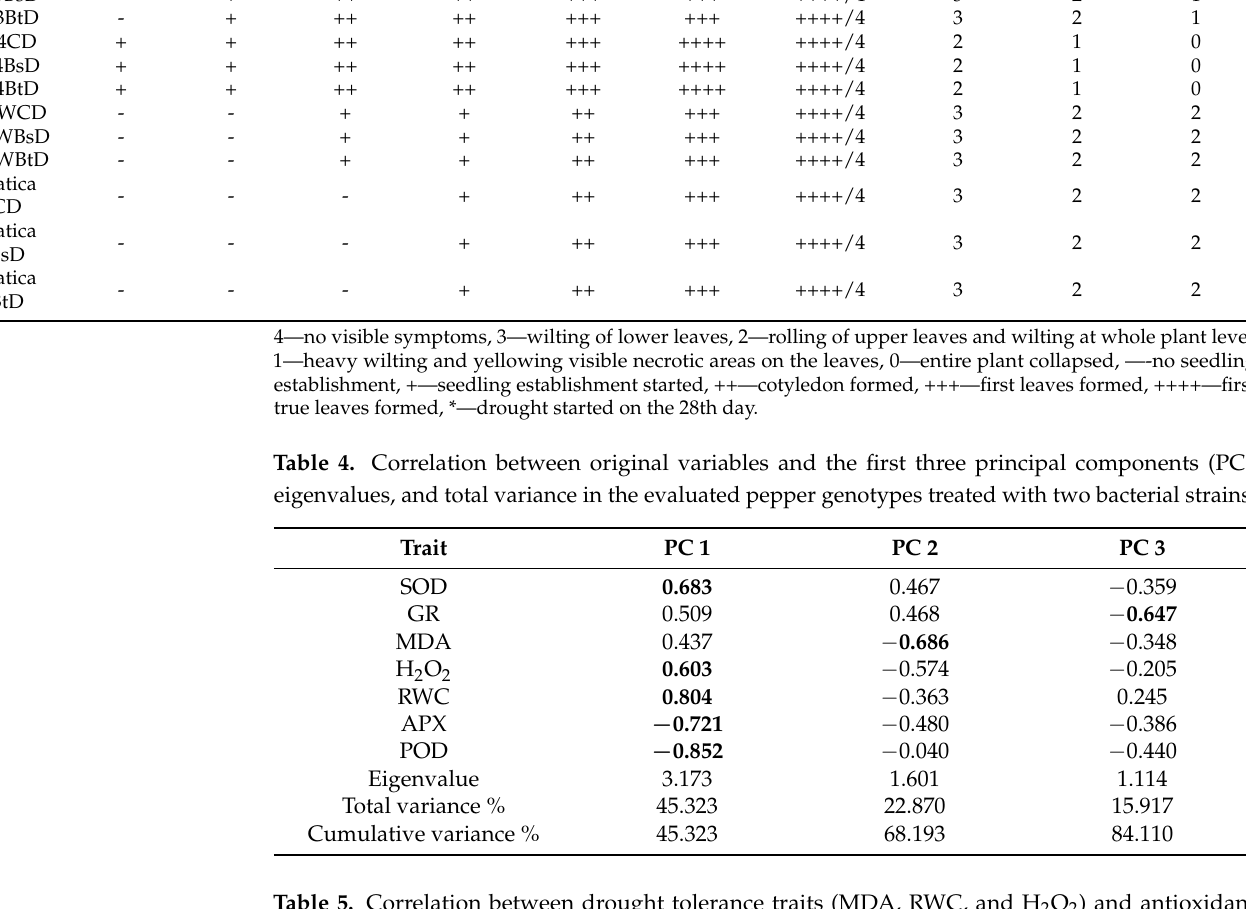
Table 5. Correlation between drought tolerance traits (MDA, RWC, and H 2 O 2 ) and antioxidant enzyme (SOD and